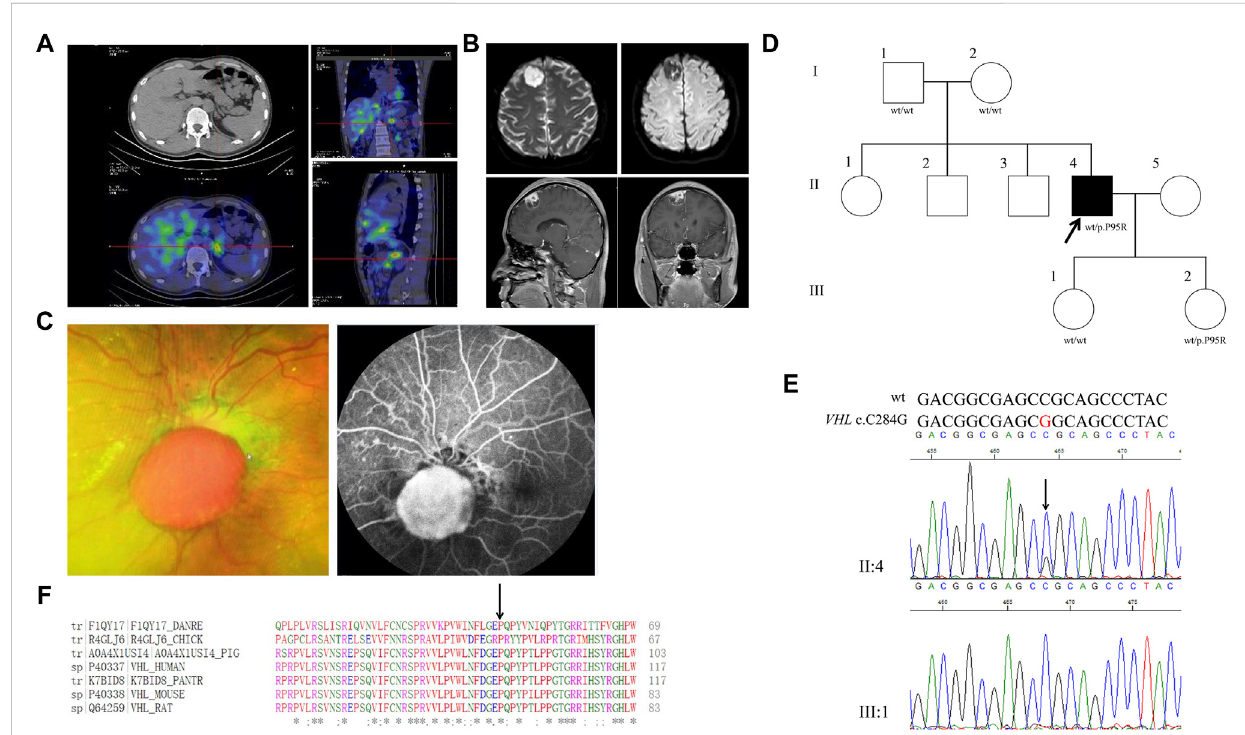
FIGURE 1 Clinical and genetic characteristics of Proband 1. (A) 131I-MIBG SPECT/CT imaging in a 30-year-old male patient with PPGL showing a focus of radioactivity distribution in the left adrenal gland. CT (upper) and SPECT/CT (bottom) transaxial sections are shown in the left column, while coronal section in the upper right and sagittal in the bottom right. (B) Dilated funduscopic examination of the patient ’ s left eye showing an orange nodular lesion (left) in the surface of optic disc and fl uorescein angiography showing leakage and marked hyper fl uorescence of the nodule, indicative of retinal hemangioblastoma (right). (C) DWI (upper) and T1WI (bottom) in the Proband 1with meningioma. DWI, Diffusion-weighted imaging; T1WI, T1-weighted image. (D) Pedigree of the Proband 1 family with PPGL. Squares and circles indicate males and females, respectively; Roman numerals indicate generations; and Arabic numerals indicate individual family members. Each member ’ s VHL genotype is shown below the squares and circles. WT, wild type.P,proline;R,arginine. (E) DNAsequencingdataofanunaffectedfemale(III:1)andtheProband1(II:4)withtheheterozygousvariantof VHL c.C284G. WT, wild type. (F) Multiple protein sequence alignmentof seven species for VHLp.P95 (arrow). An asterisk (*) indicates positions that are 100% conserved in the alignment, and a colon (:) indicates conservation between groups of strongly similar properties, whilst a period (.) indicates conservation between groups of weakly similar properties. The residues in the alignment are colored to indicate their physicochemical properties. Red indicates small and hydrophobic amino acids, blue indicates acidic residues, magenta indicates basic and green denotes hydroxyl/sulfhydryl/amine